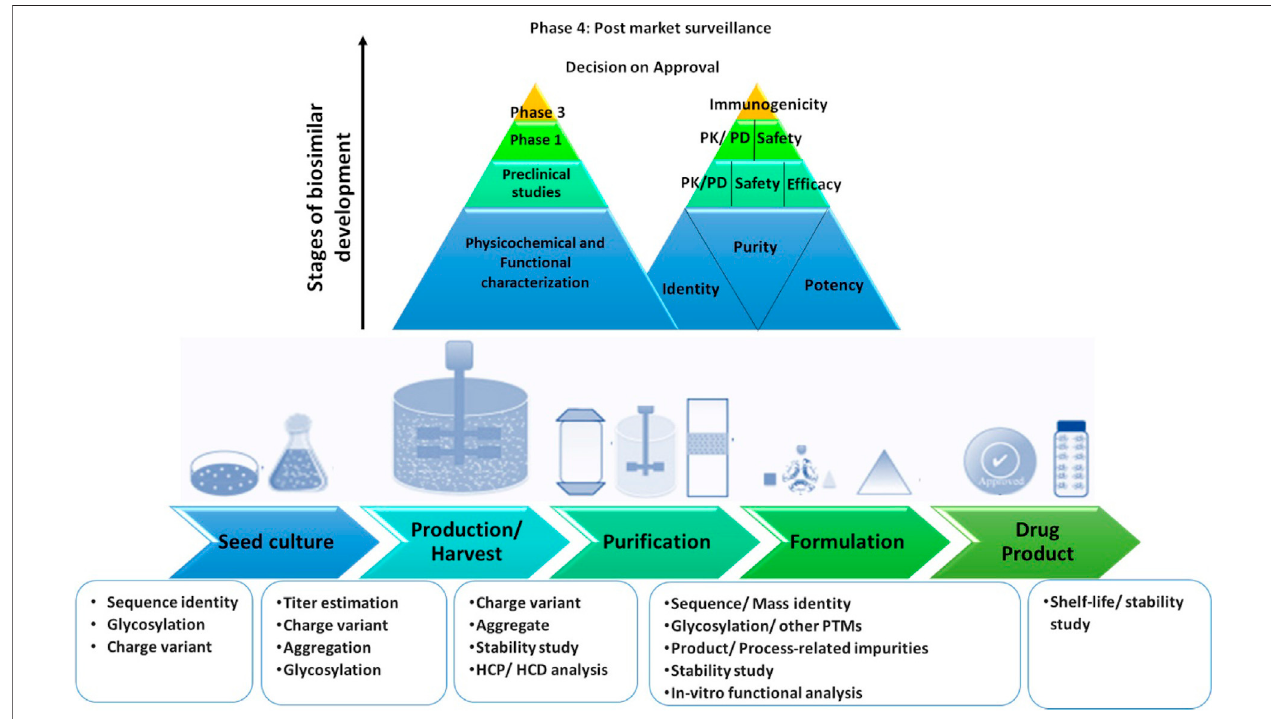
FIGURE 1 | Bioprocess train with multiple stages of development during biosimilar manufacturing. PK, Pharmacokinetics; PD, Pharmacodynamics; PTM, Post translational modi fi cations; HCP, Host Cell Protein; HCD, Host Cell DNA.